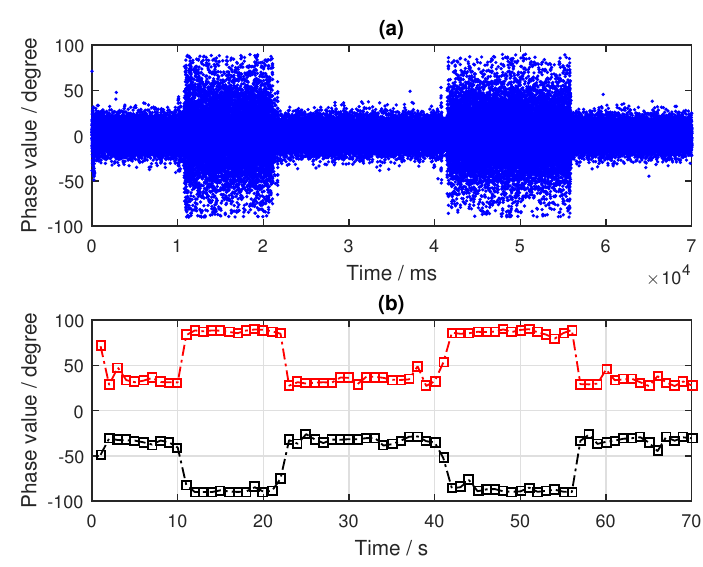
Figure 11. Results of the BeiDou satellite (PRN9) reflected signal: ( a ) phase difference information (in ms); ( b ) phase difference information (in s).